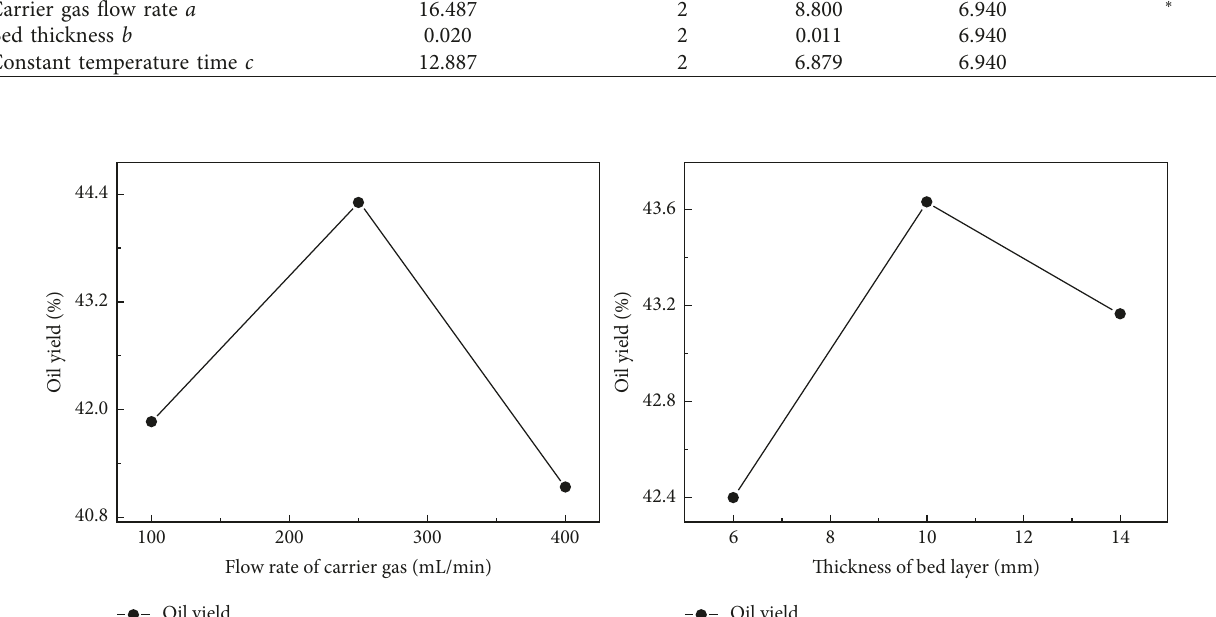
Figure 2: Pyrolysis orthogonal experiment ( L